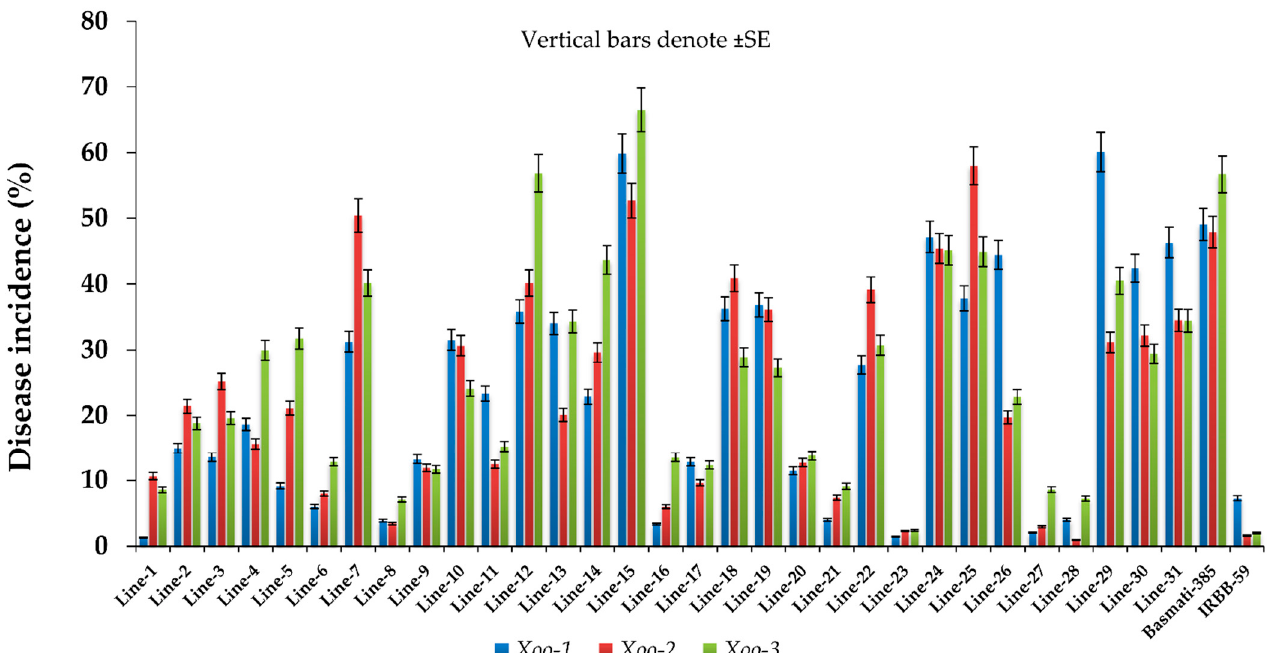
Figure 7. Lesion developed by Xoo isolates on advanced RILs of rice.